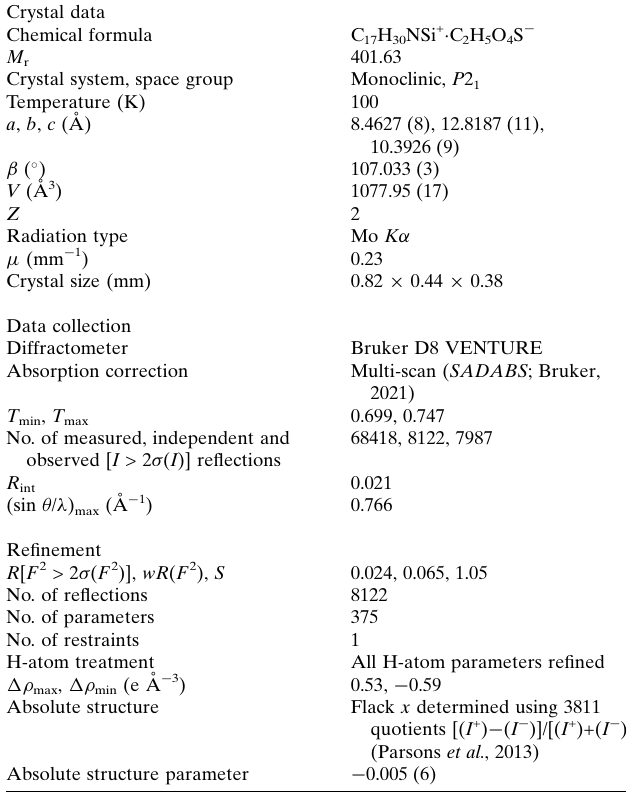
Table 3 Experimental details. Crystal data Chemical formula